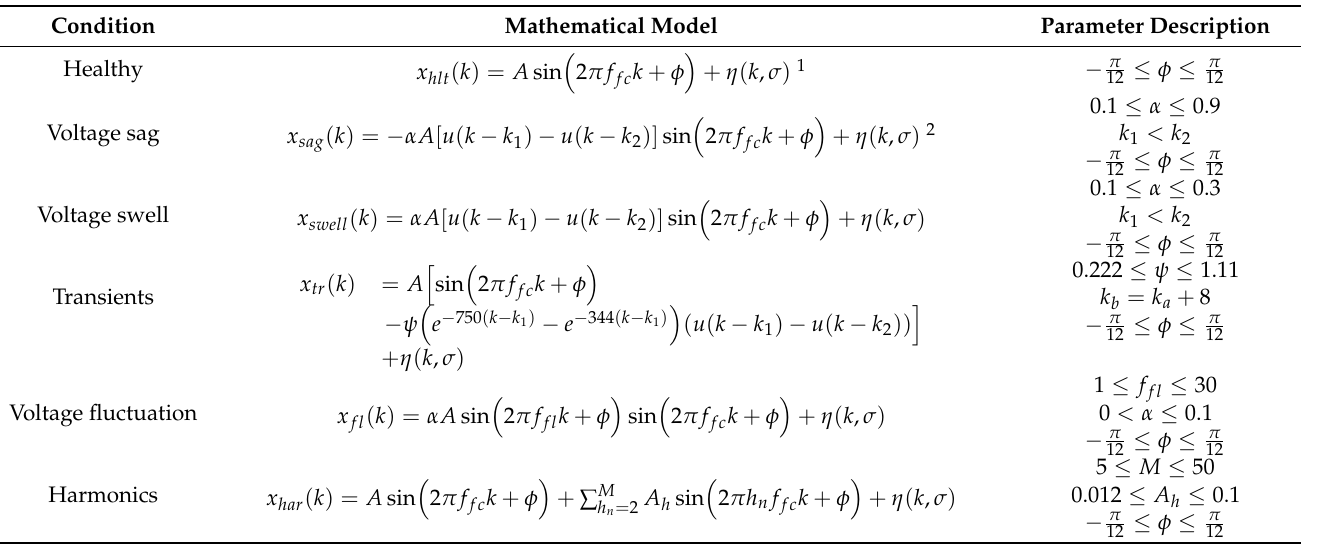
Table 1. Mathematical models used in the generation of the synthetic signals for the 6 different conditions.